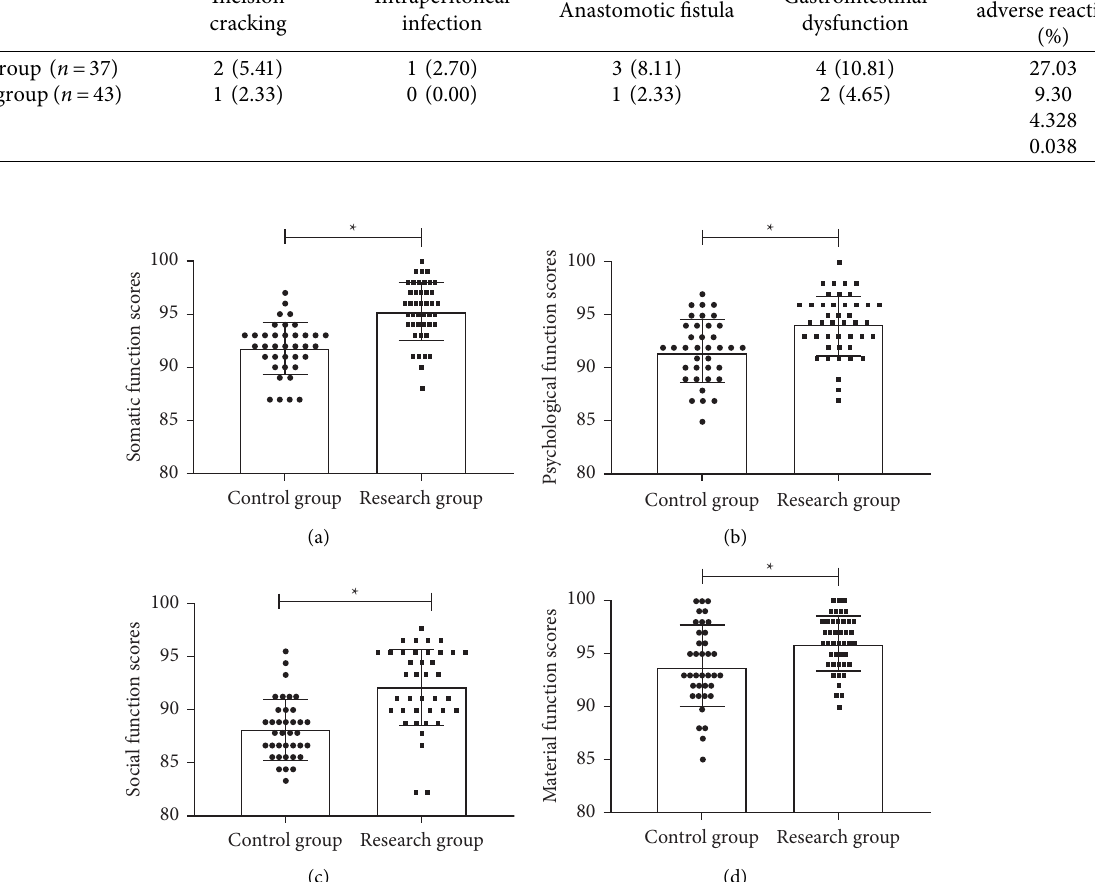
Figure 4: Comparison of GQOL-74 scores. Note: (a) comparison of somatic function scores; (b) comparison of psychological function scores; (c) comparison of social function scores; (d) comparison of material function scores. ∗ P <